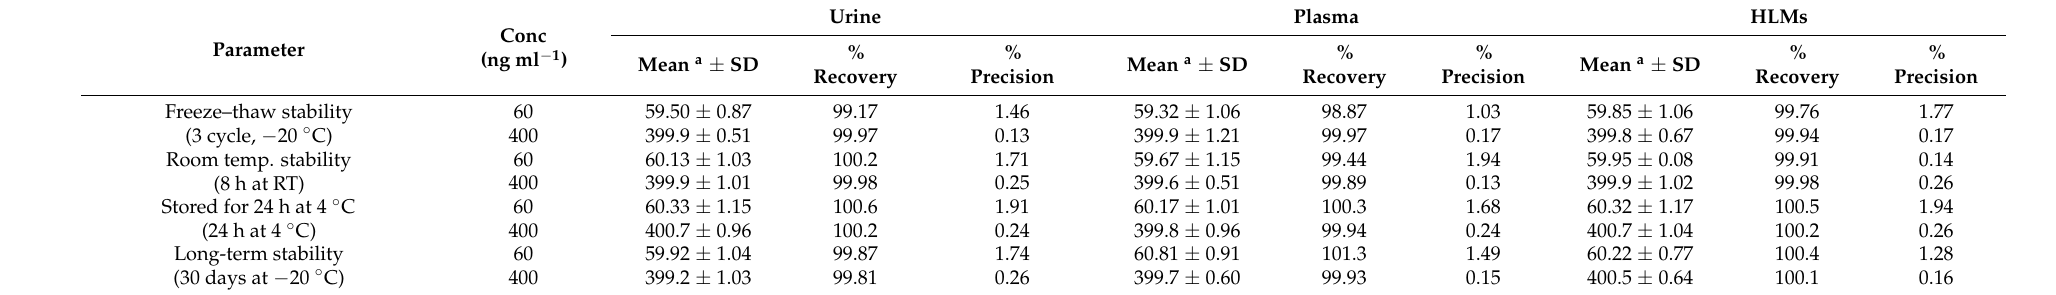
Table 4. Precision and accuracy calculated from stability experiments for